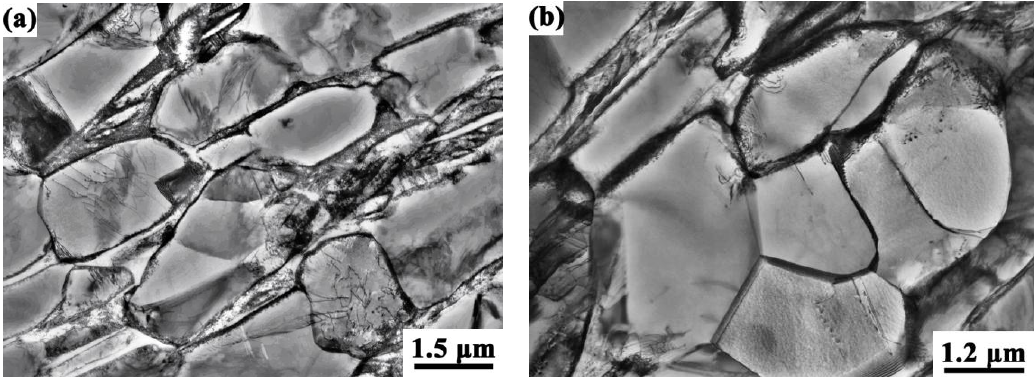
Figure 10. TEM images of Ti-6Al-4V specimens deformed at 900 °C/10 −3 s −1 : ( a ) breakdown of the lamellar structure and ( b ) subgrains inside the recrystallized grains.